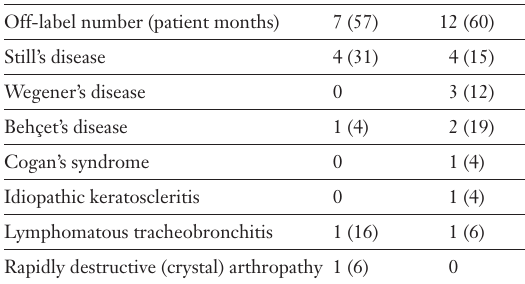
Diagnoses of the patients treated with etanercept (Enbrel ® ) or infliximab (Remi- cade ®